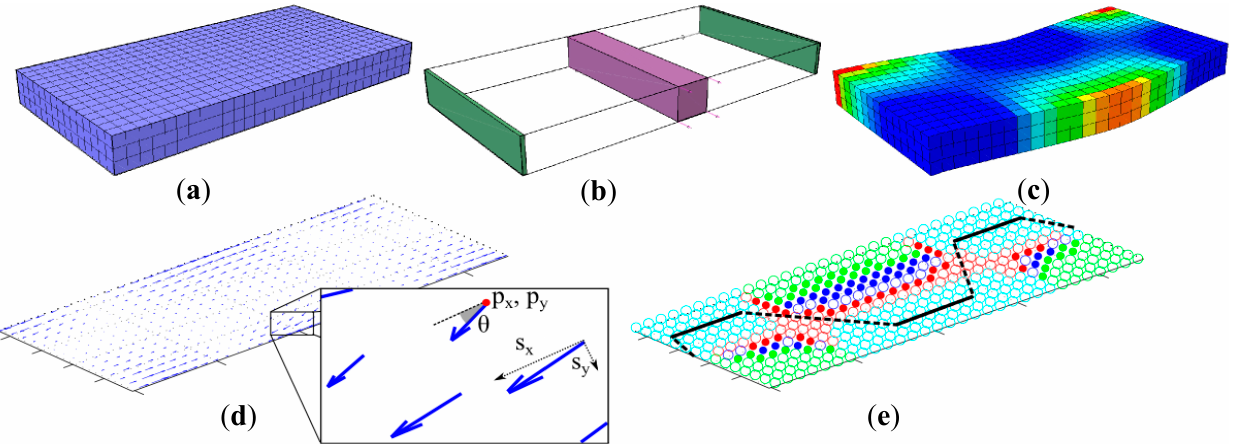
Figure 3. Overall process of SVAS 3 explained with an example soft structure block. ( a ) Soft body constructed with voxels; ( b ) constraints and stimulus applied and ( c ) soft body deformation simulated; ( d ) Strain vectors are extracted from deformations and ( e ) clustered to generate the final sensor